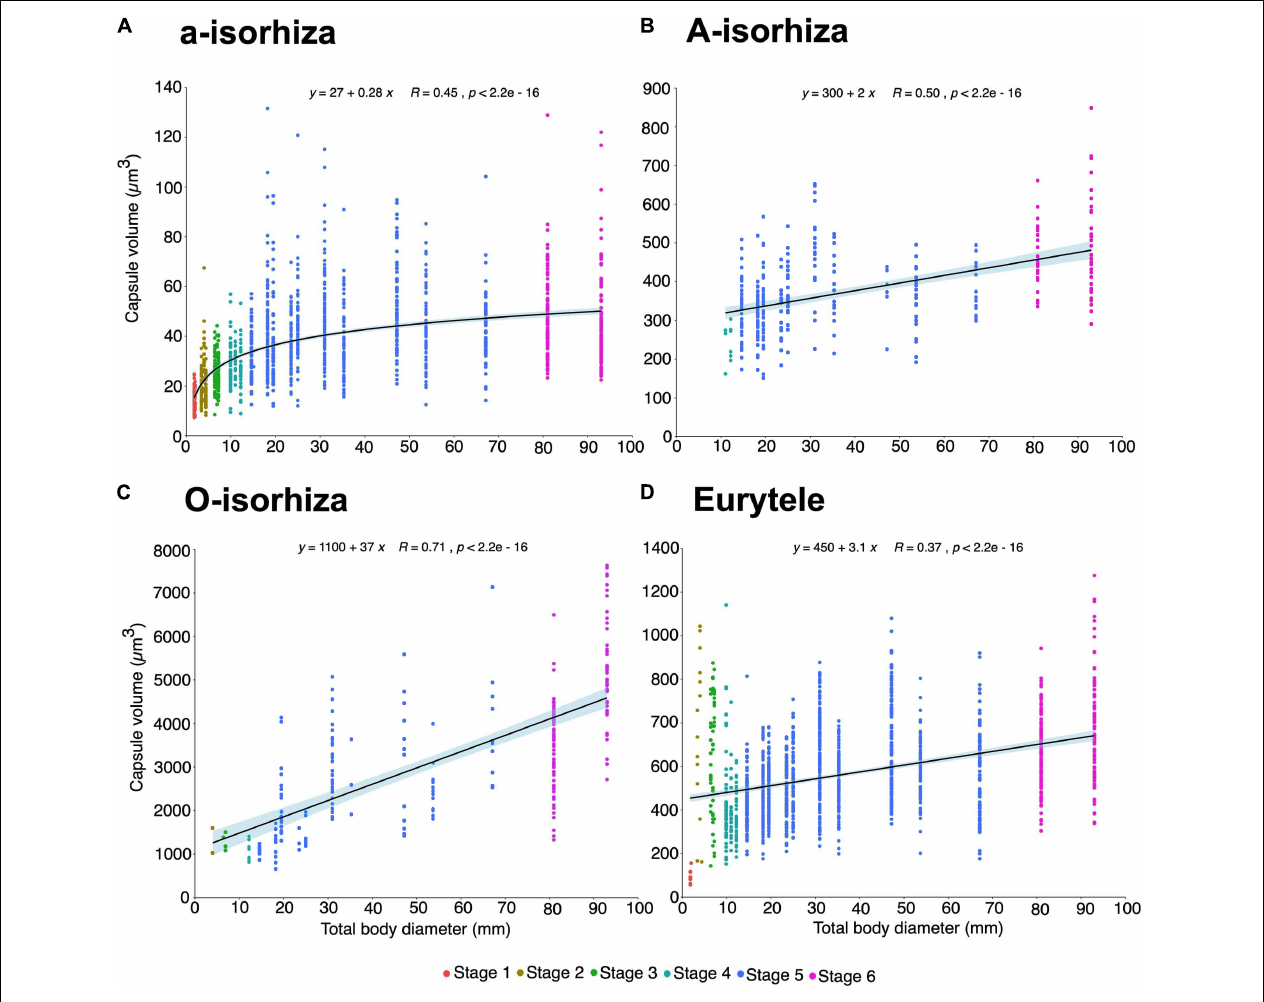
FIGURE 9 | Increase in capsule volume (CV) during the growth of Pelagia noctiluca . Regression lines indicate a positive correlation between increasing total body diameter (TBD) and increasing nematocyst capsule volumes. (A) a-isorhizas (1389 nematocysts). (B) A-isorhizas (318 nematocysts). (C) O-isorhizas (246 nematocysts). (D) Euryteles (1487 nematocysts). Note largest capsule volume during early stages corresponds to euryteles in gastric filaments. Stages: ephyra, stage 1; ephyra, stage 2; metaephyra, stage 3; metaephyra, stage 4; juvenile medusa, stage 5; adult medusa, stage